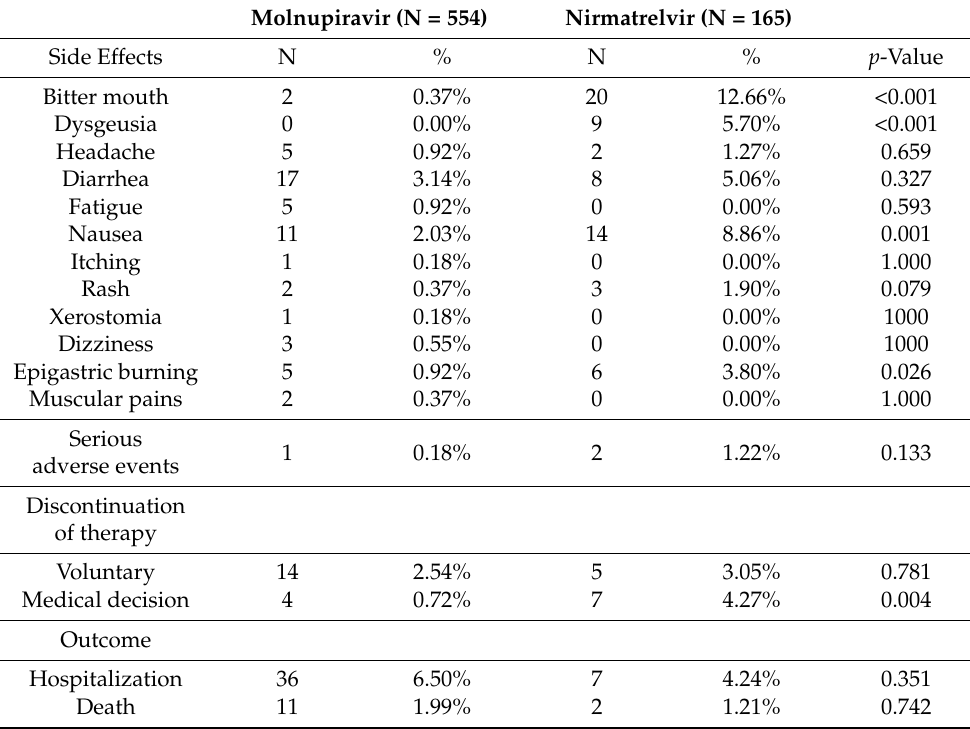
Table 2. Safety profile and outcome according to the antiviral